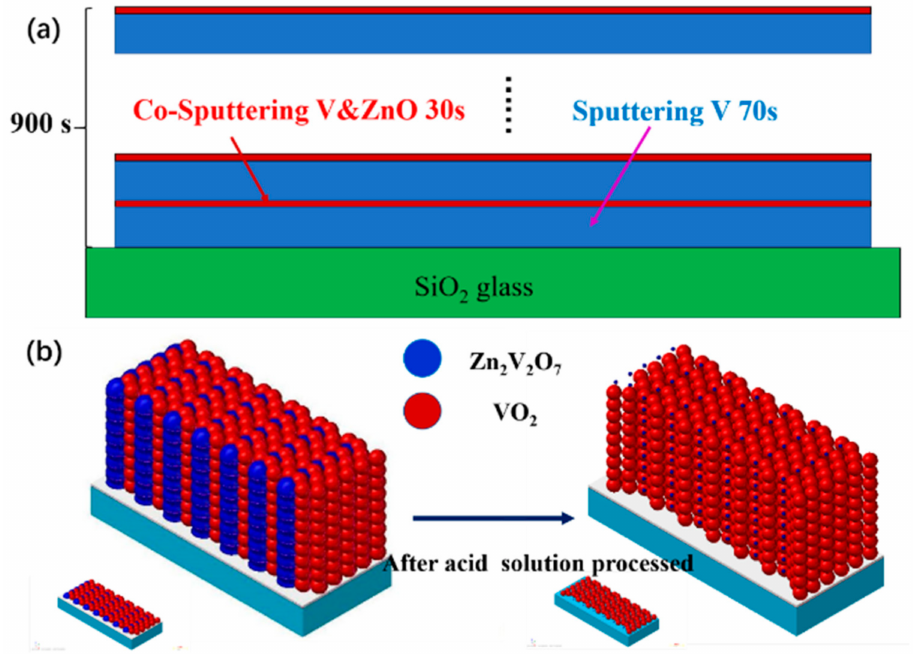
Figure 1. ( a ) the diagram for the ZnO-V composite film preparation process and ( b ) film structure before and after acid solution